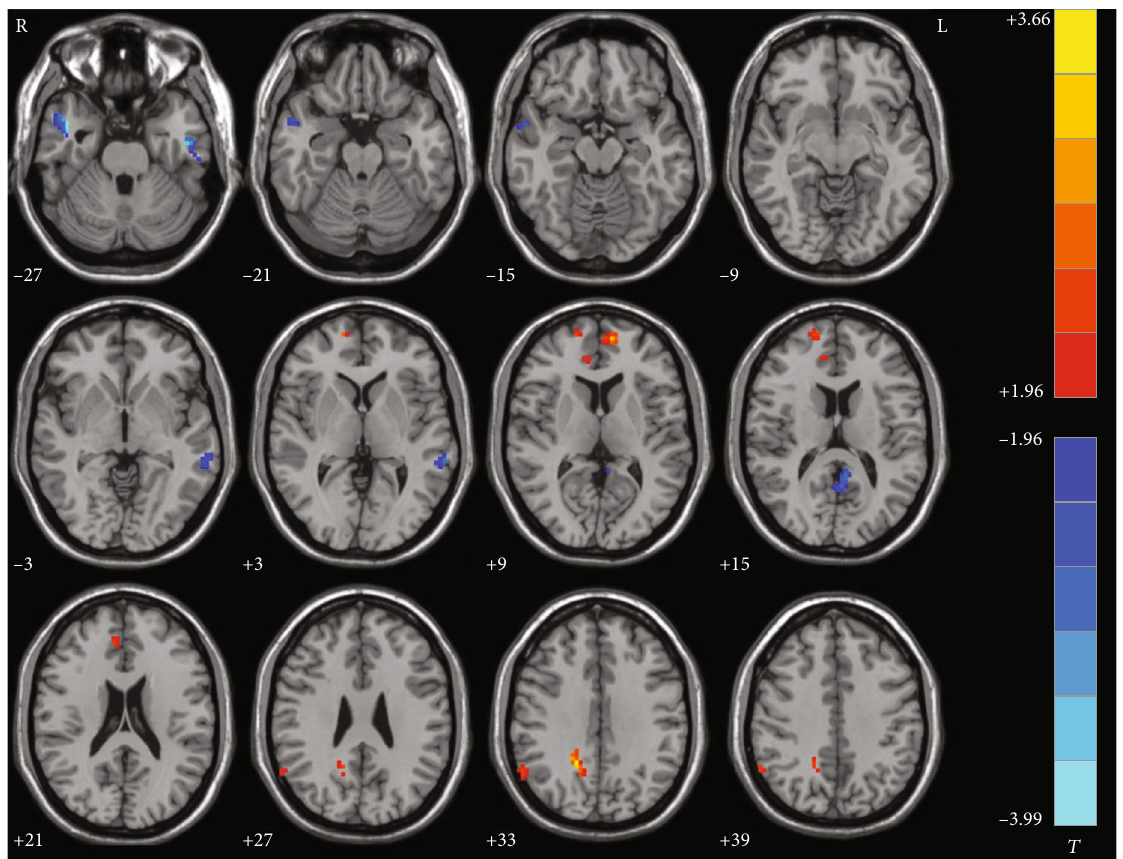
Figure 2: Statistical map depicts higher and lower NH of melancholic patients compared with healthy controls. The threshold was set at p < 0 : 05 . Blue denotes lower NH and red denotes higher NH. Color bar indicates T values from two-sample t -test. L: left side; R: right side; DMN: default mode network; NH: network